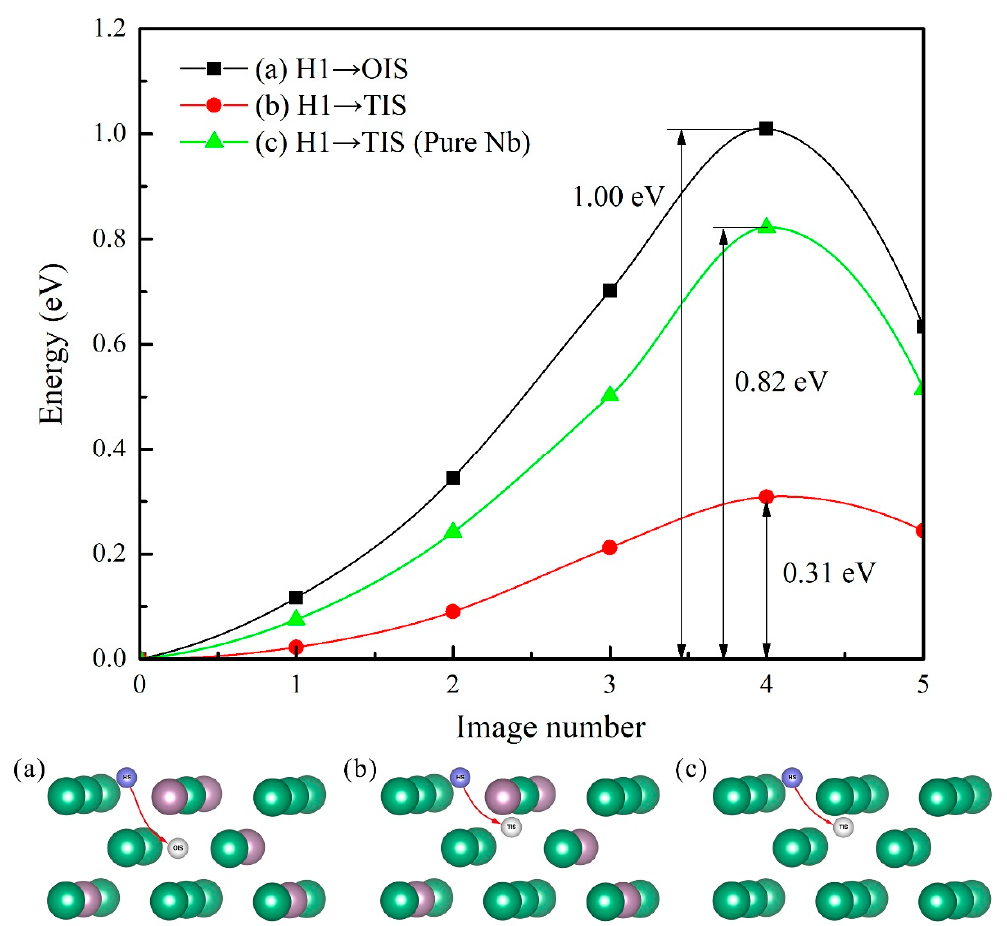
Figure 6. Energy barriers of H-atom diffusion in different path. ( a ) H1 to OIS in Mo-doped Nb (100) surface, ( b ) H1 to tetrahedral interstitial site in Mo-doped Nb (100) surface, and ( c ) HS to TIS in pure Nb (100) surface. Blue balls represent the starting position and white balls represent the finish position for H atoms.